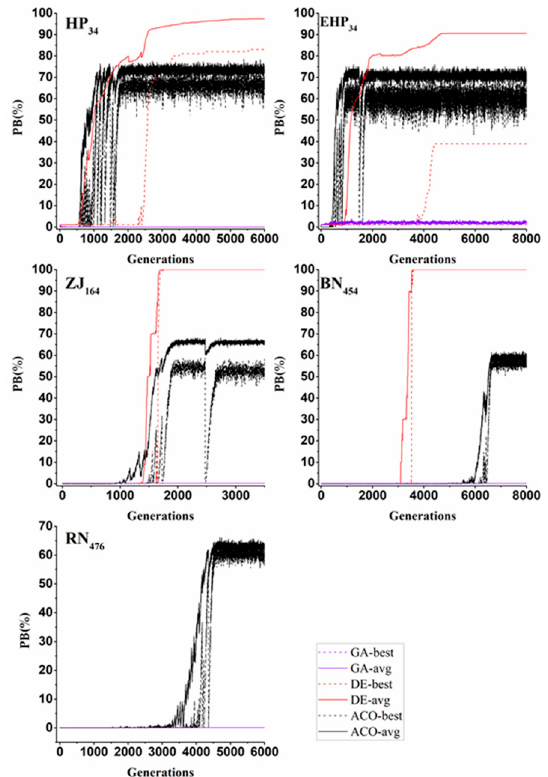
Figure 6. Solution quality metric 𝑃𝐵% of the three different types of EAs applied to the five case studies.